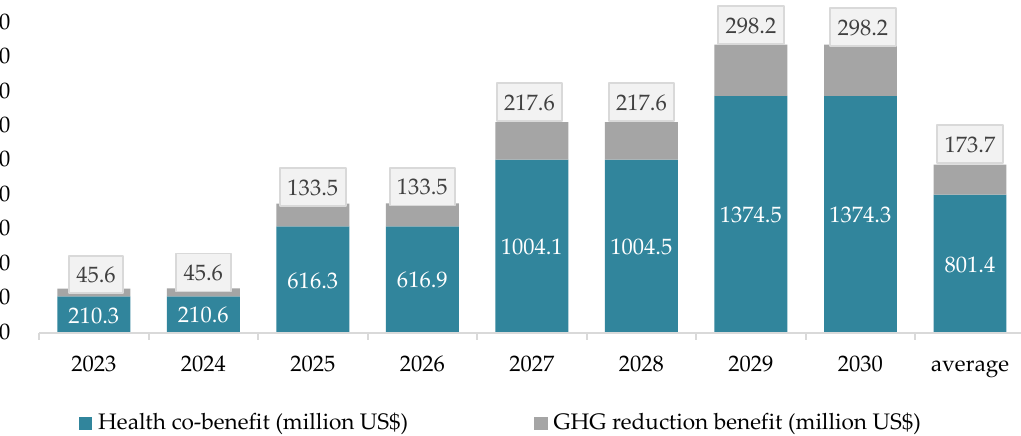
Figure 7. Simulated GHG reduction benefits and health co-benefits for Scenario 2 in 2023–2030.